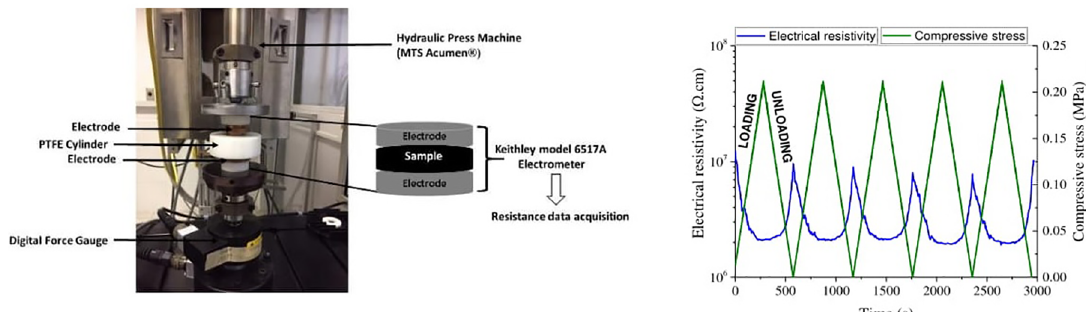
Figure 1. Electromechanical test device and performance graph for 5 loading-unloading consecutives